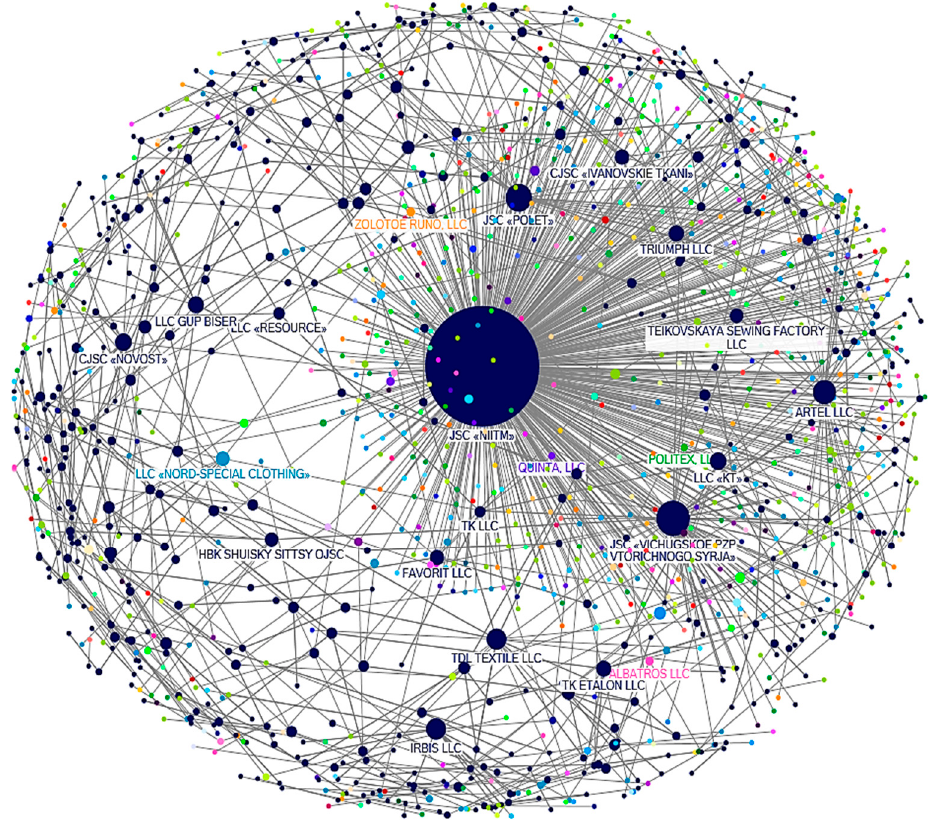
Figure 3. The Ivanovo region’s network of enterprises of the textile industry. Enterprises established in the Ivanovo region are marked in dark blue. Enterprises from other regions are in different colors.